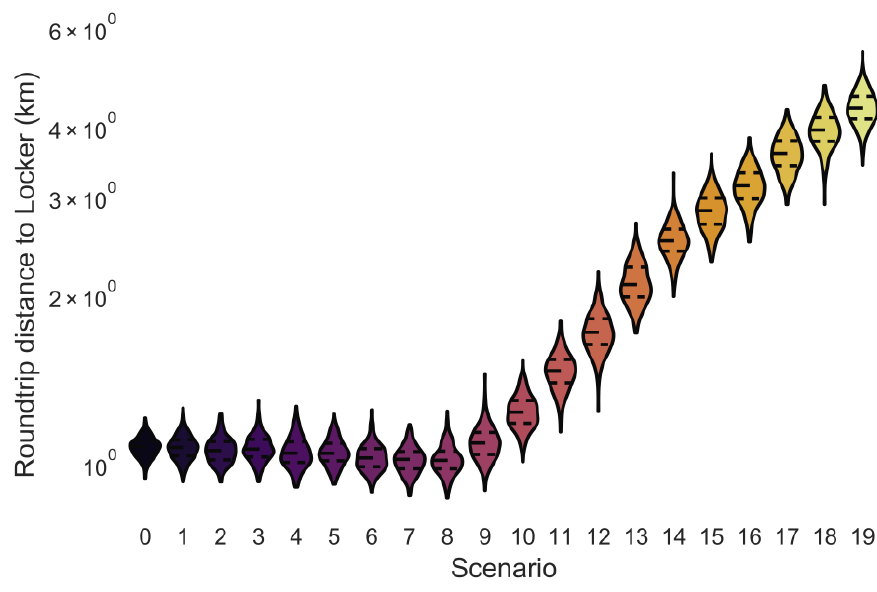
Figure 2. Average roundtrip distance to between lockers and customer’s homes.